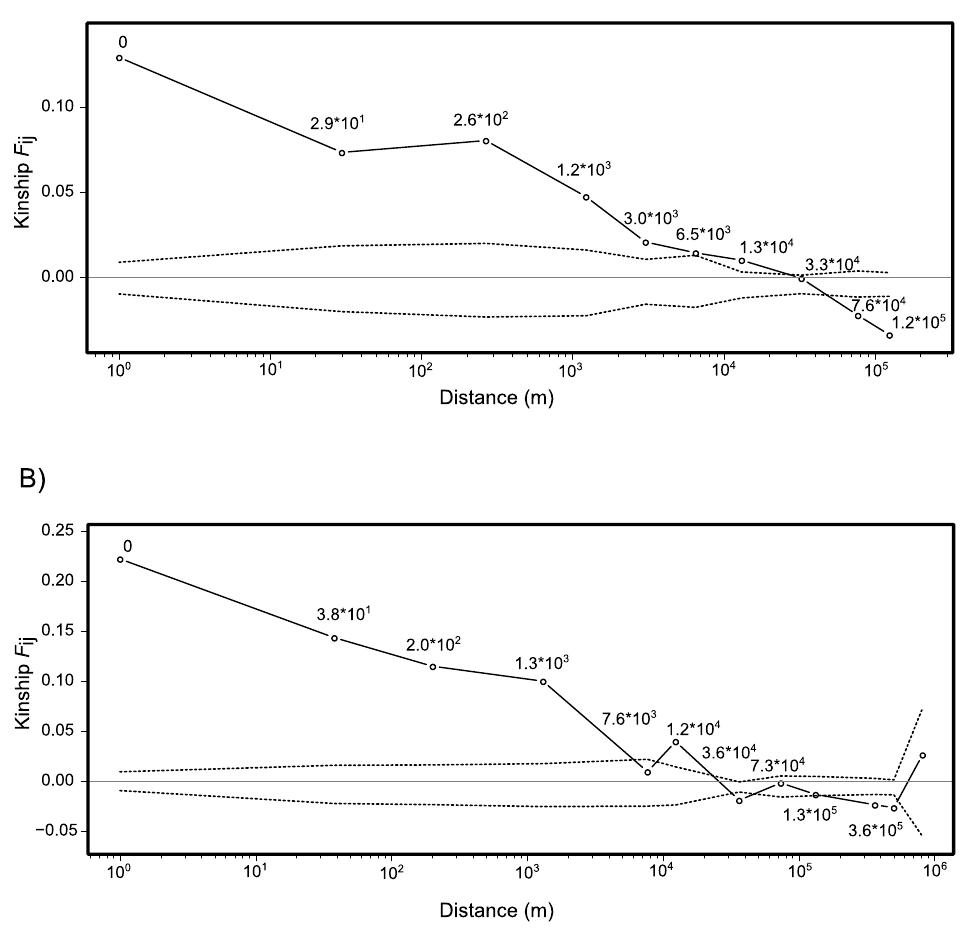
Figure 4. Correlograms of kinship coefficients ( Fij ) per distance class represented on a logarithm scale; ( A ) for cluster A identified by STRUCTURE; ( B ) for cluster B. The plain line represents the value measured on the data. The dotted line represents the confidence interval of the permutations and indicates the null expectation of no spatial genetic structure. The circles show the mean distance estimated inside a particular distance class (see Methods). Closed circles indicate values significantly different from the null expectation while open circles correspond to the null expectation.